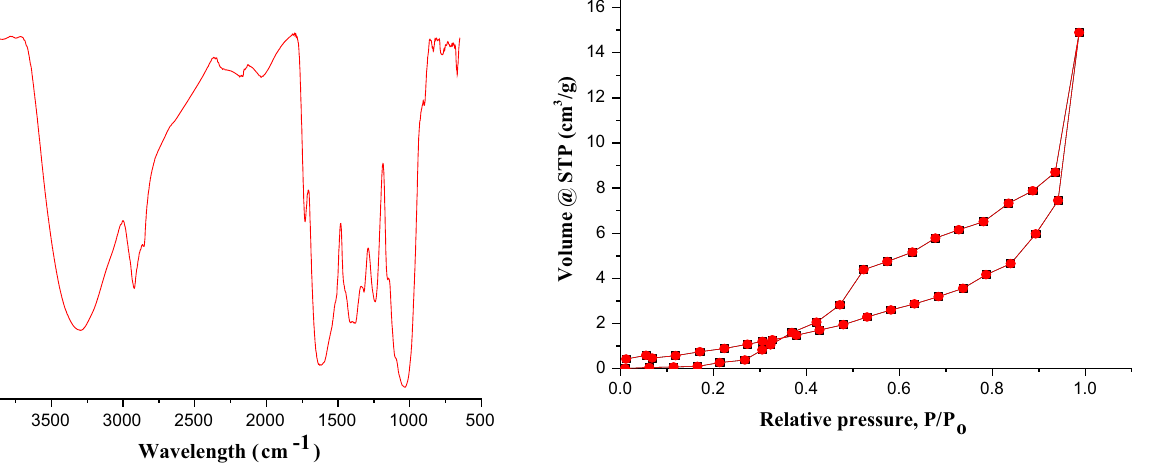
Fig. 3 Adsorption–desorption isotherm plot of powdered Albizia leb- beck